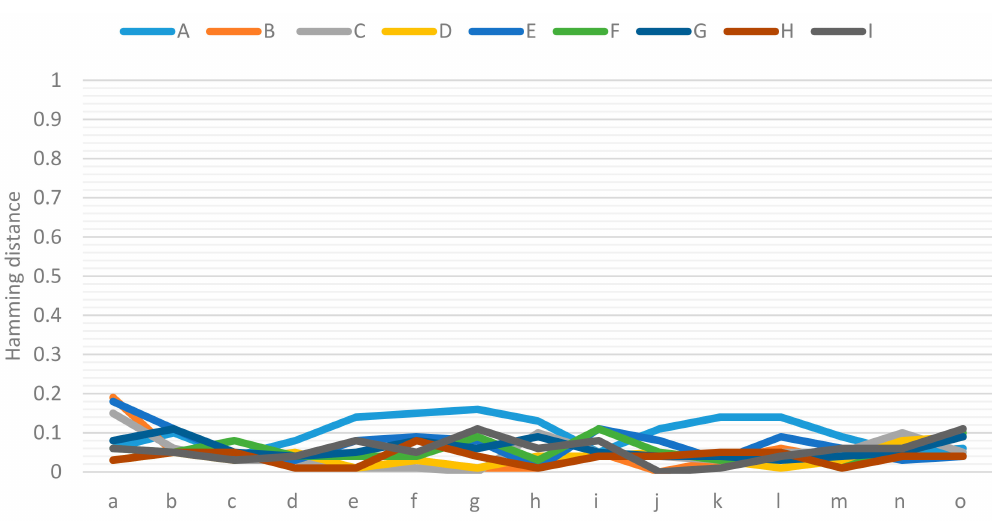
Figure 1. Hamming distance between expert groups in cause–effect relationships. Source: own